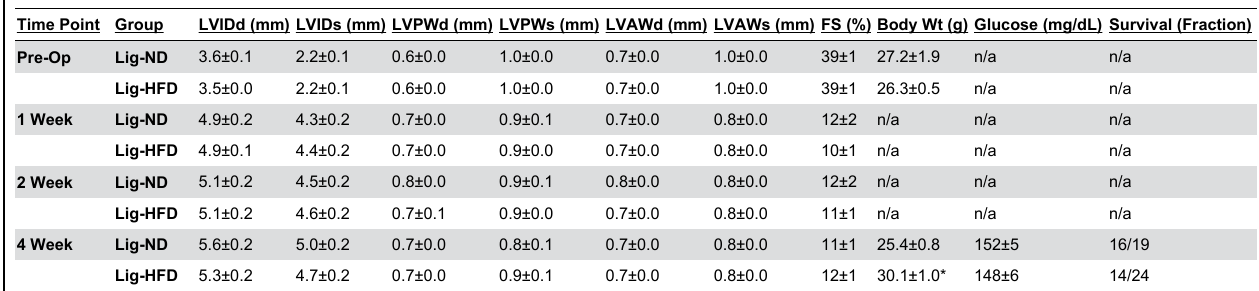
Table 1. Left ventricular diameters, wall thicknesses, and fractional shortening of post-fed HFD group; additionally, body weight, blood glucose, and survival